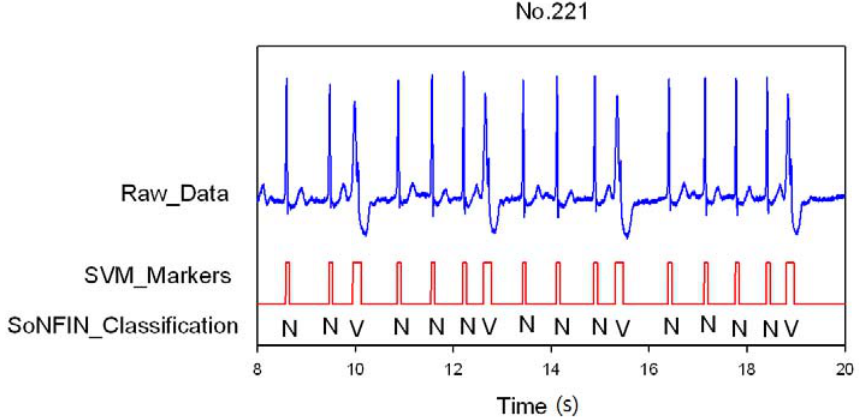
Figure 5. SVM marks the heartbeats of ECG and then SoNFIN classifies the NSR and PVC beats for file No. 221, in which “N” and “V” denotes NSR and PVC, respectively.